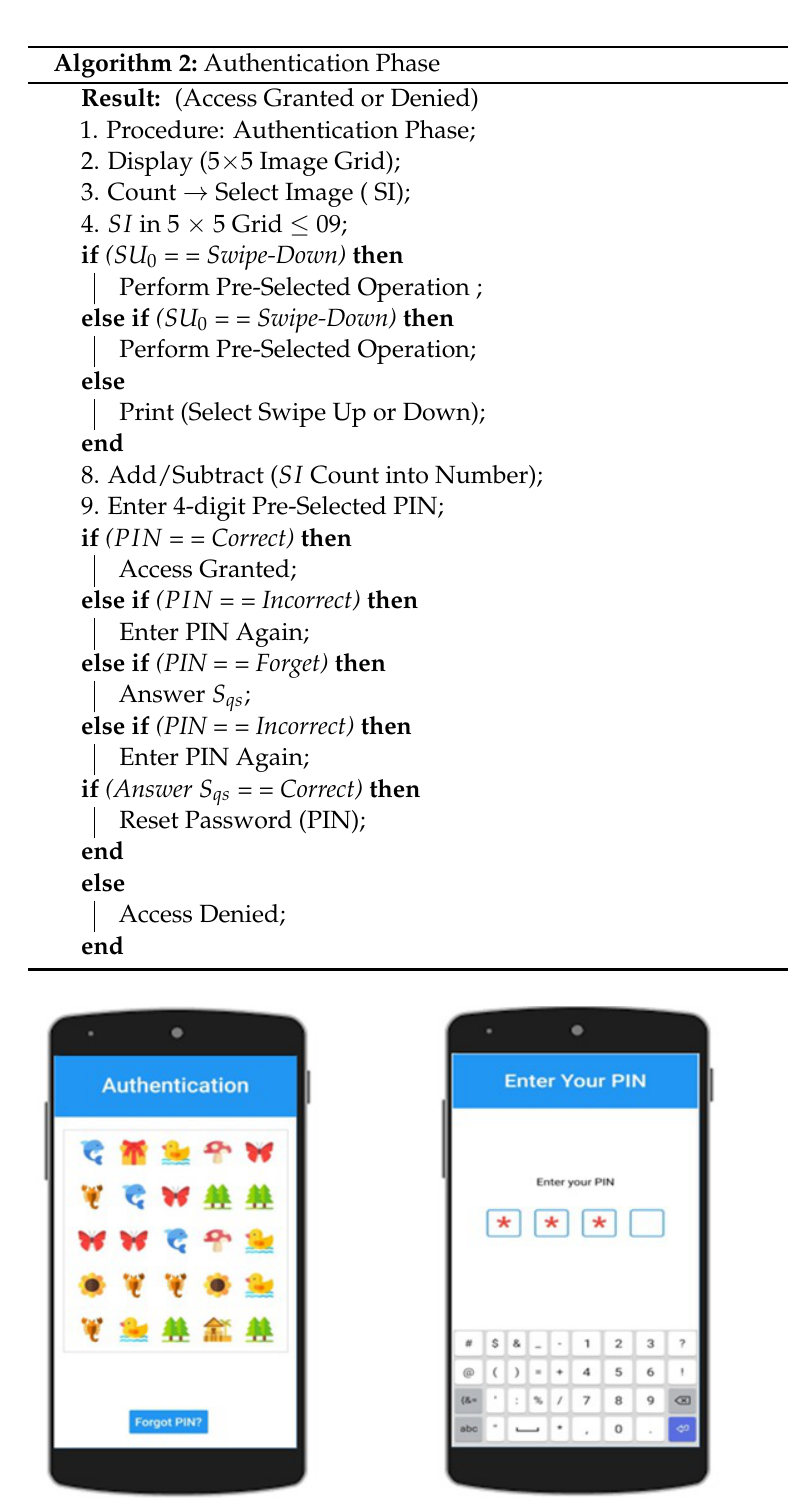
Figure 4. Count pre-selected images and enter the